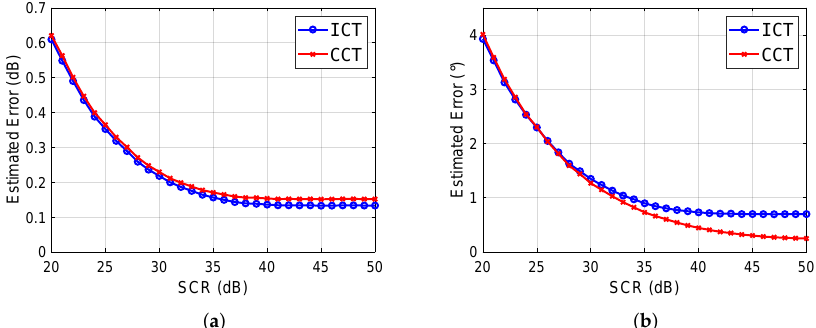
Figure 11. Simulation of distortion parameters estimation error with different SCR. ( a ) | A 1 | (dB).